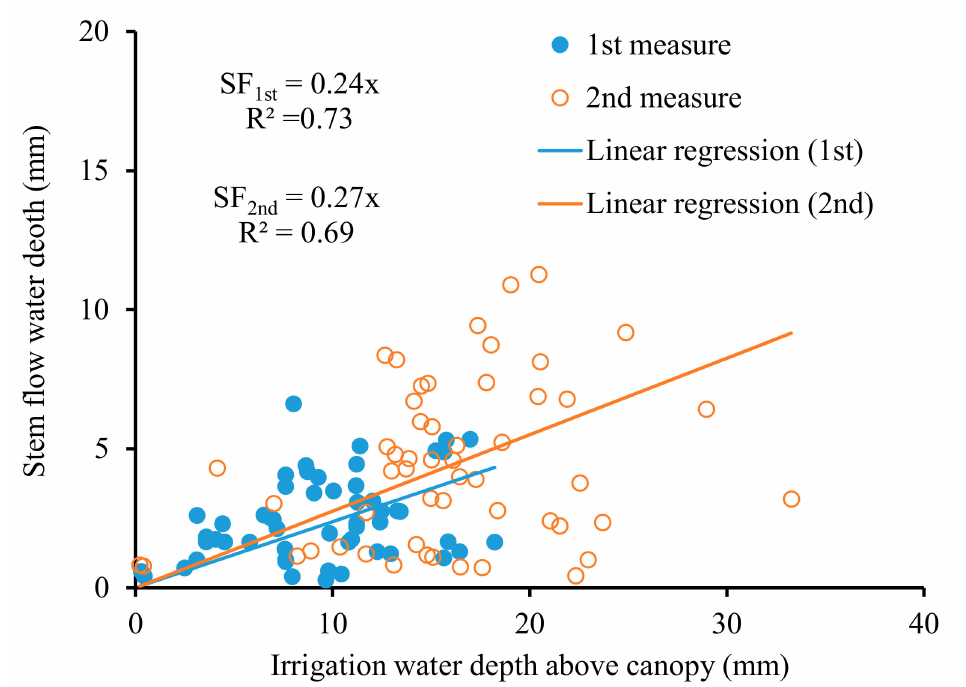
Figure 5. Stemflow water and the corresponding irrigation water depth above the canopy at the same site in the first and second measurements. SF 1st and SF 2nd represent the sap flow variable in the first and second measurements in the regression lines,